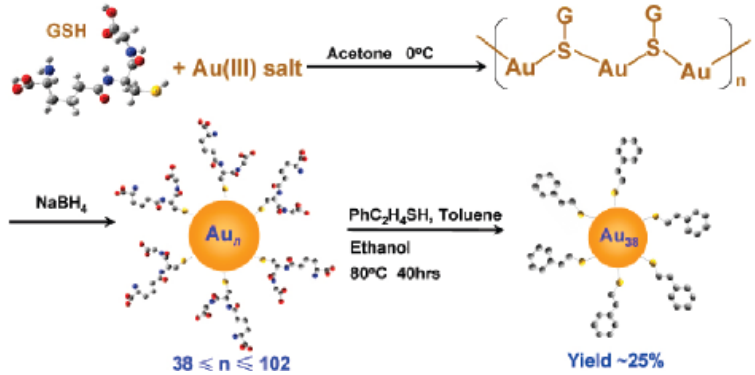
Figure 6. A two-step procedure for synthesizing monodisperse Au in high yield